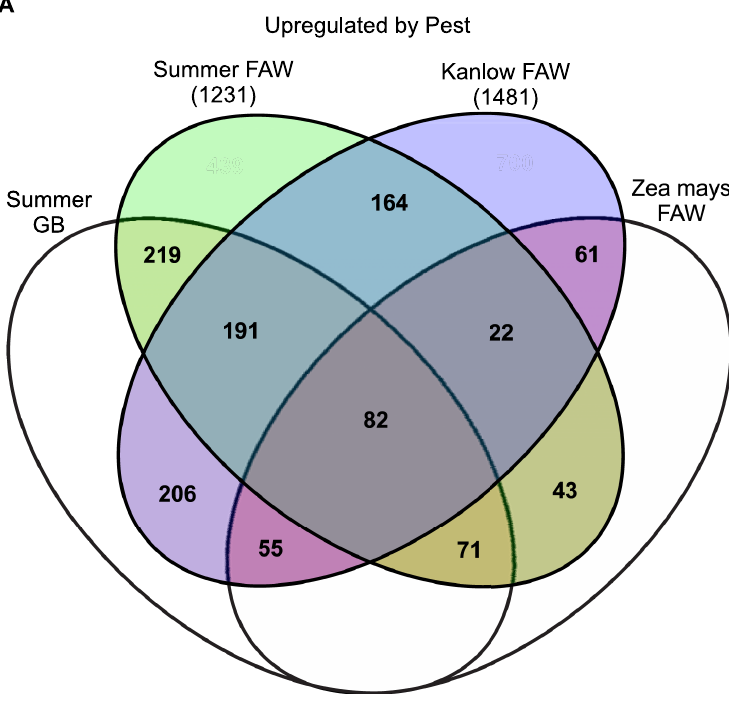
PLOS ONE | https://doi.org/10.1371/journal.pone.0218352 June 13,